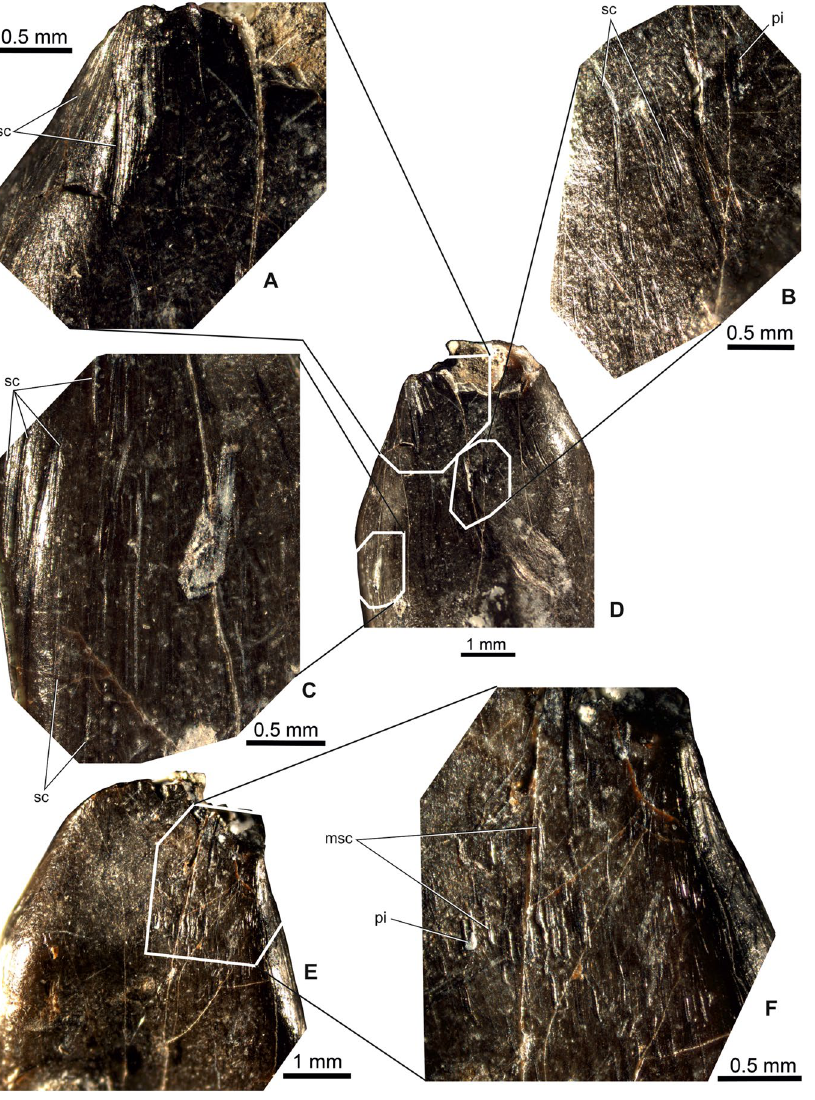
Figure 3. Wear pattern of the basal titanosauriform tooth (MTM PAL 2017.1.1.) from the Santonian of Iharkút, Hungary. ( A–C ) Details of the worn surface of labial ( D ) side. ( E ) Lingual view of the tooth crown; ( F ) ‘meteor shower’ pattern of short scratches and pits on the lingual surface of the crown. Abbreviations: msc, ‘meteor shower’ pattern of short scratches; pi, pit; sc,